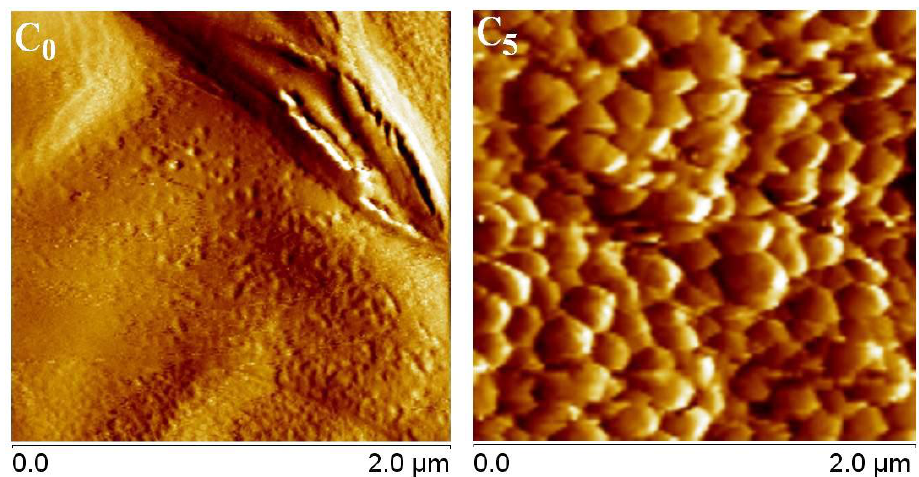
Figure 6. Atomic force microscopy (AFM) topographic images of structured coatings: monolayer hybrid hexadecyltrimethoxysilane/ tetramethoxysilane (C 16 TMS/TMOS) film ( coating C 0 ), and bilayer coating (C 16 TMS/TMOS + 0.01 g of SiO 2 NPs functionalized with methoxydimethyloctylsilane (DMeC 8 MS) dispersed in 1 mL EtOH, coating C 5 ).